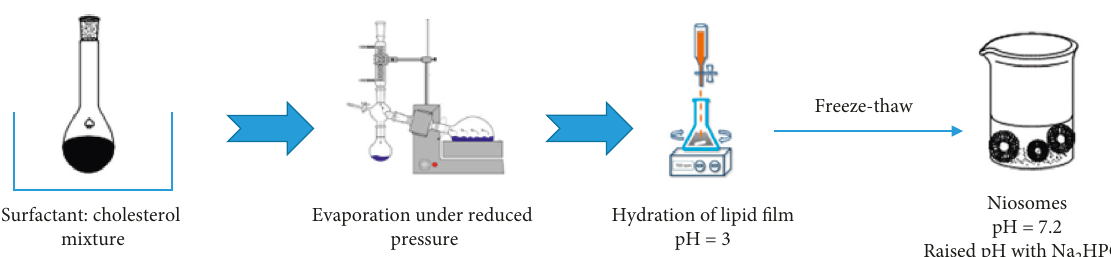
Surfactant: cholesterol mixture Figure 8: Schematic nonionic surfactant vesicles (niosomes) formation by transdermal pH gradient method.